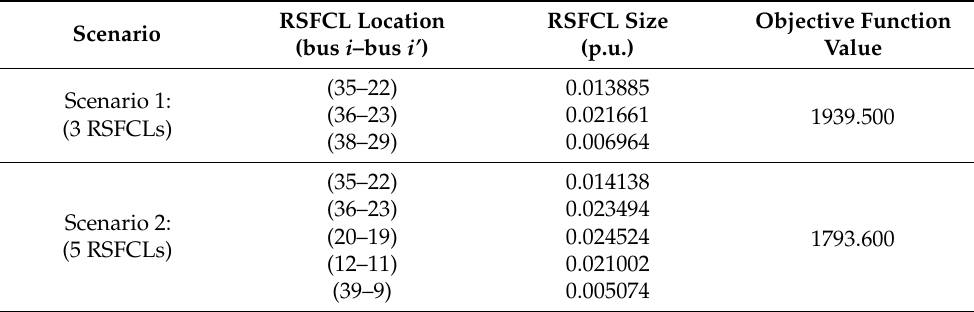
Table 3. Optimization results of the 39-bus New England case